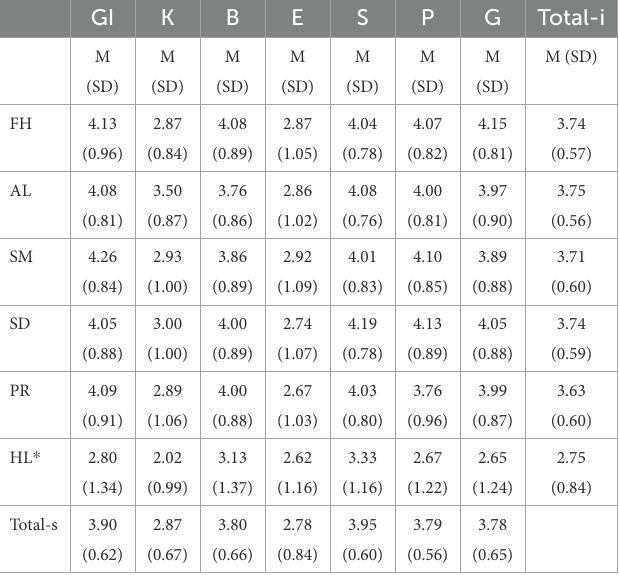
TABLE 2 Participants’ interest in personalized medicine.